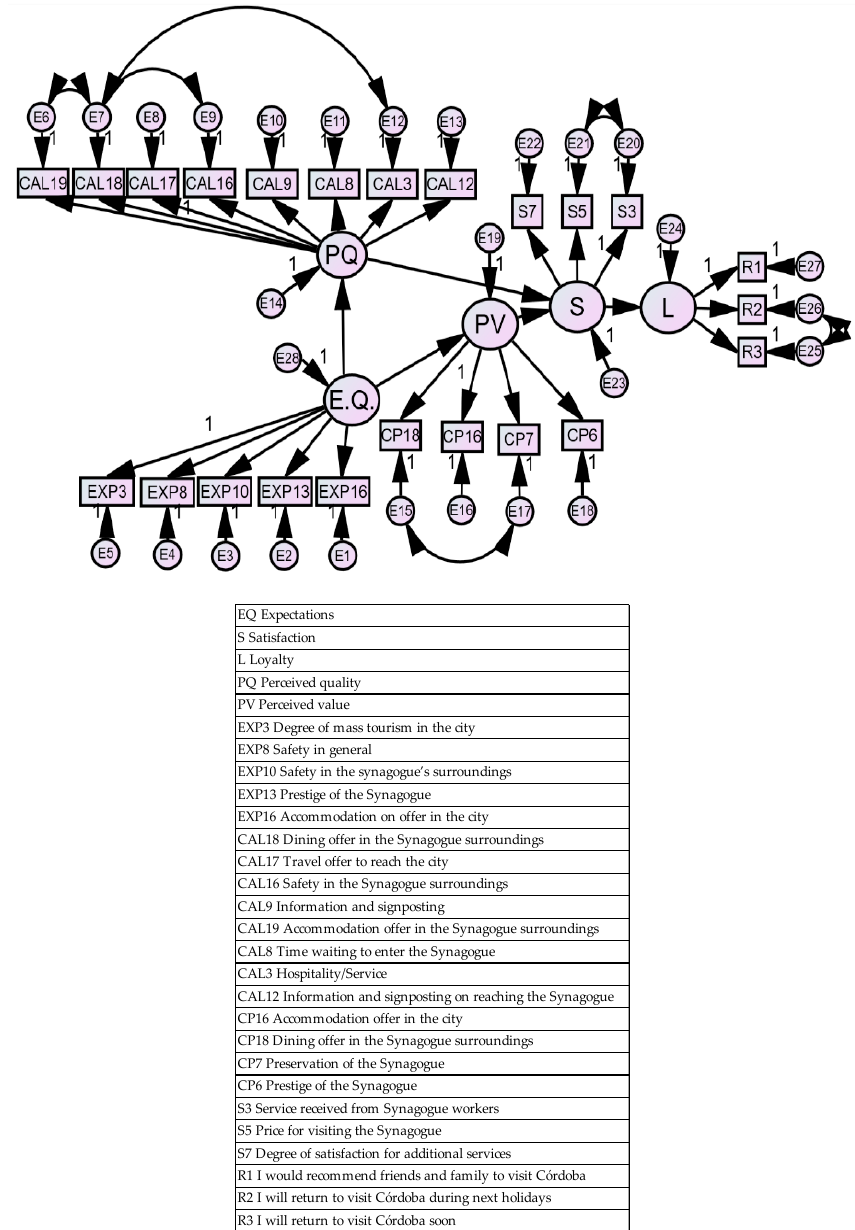
Figure 2. Path diagram of the proposed model.